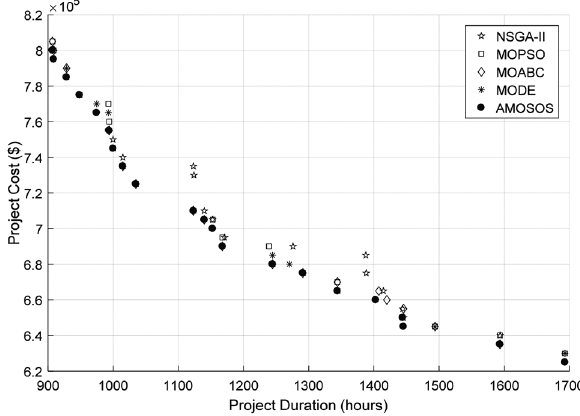
Figure 9. Pareto fronts obtained using five algorithms